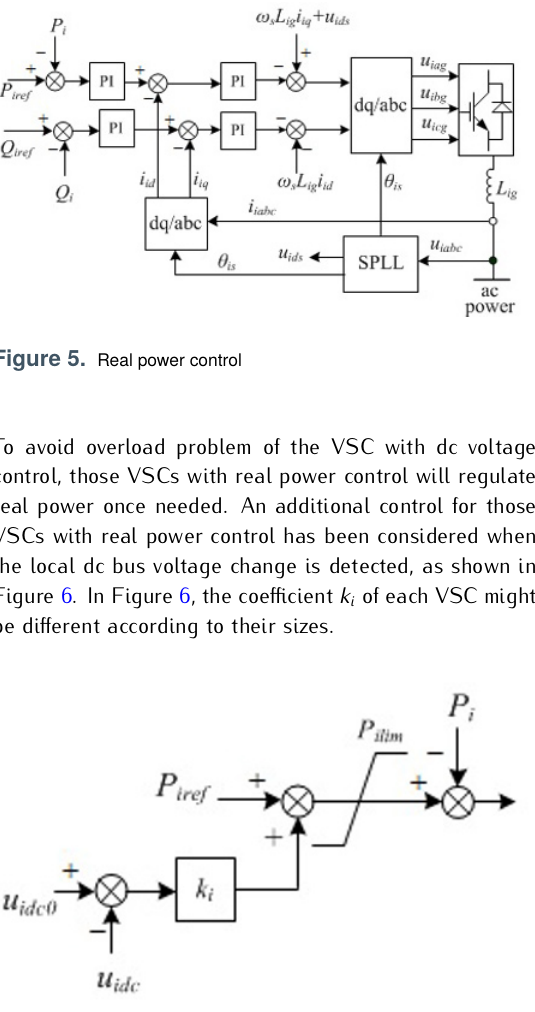
Figure 6. An additional control for real power